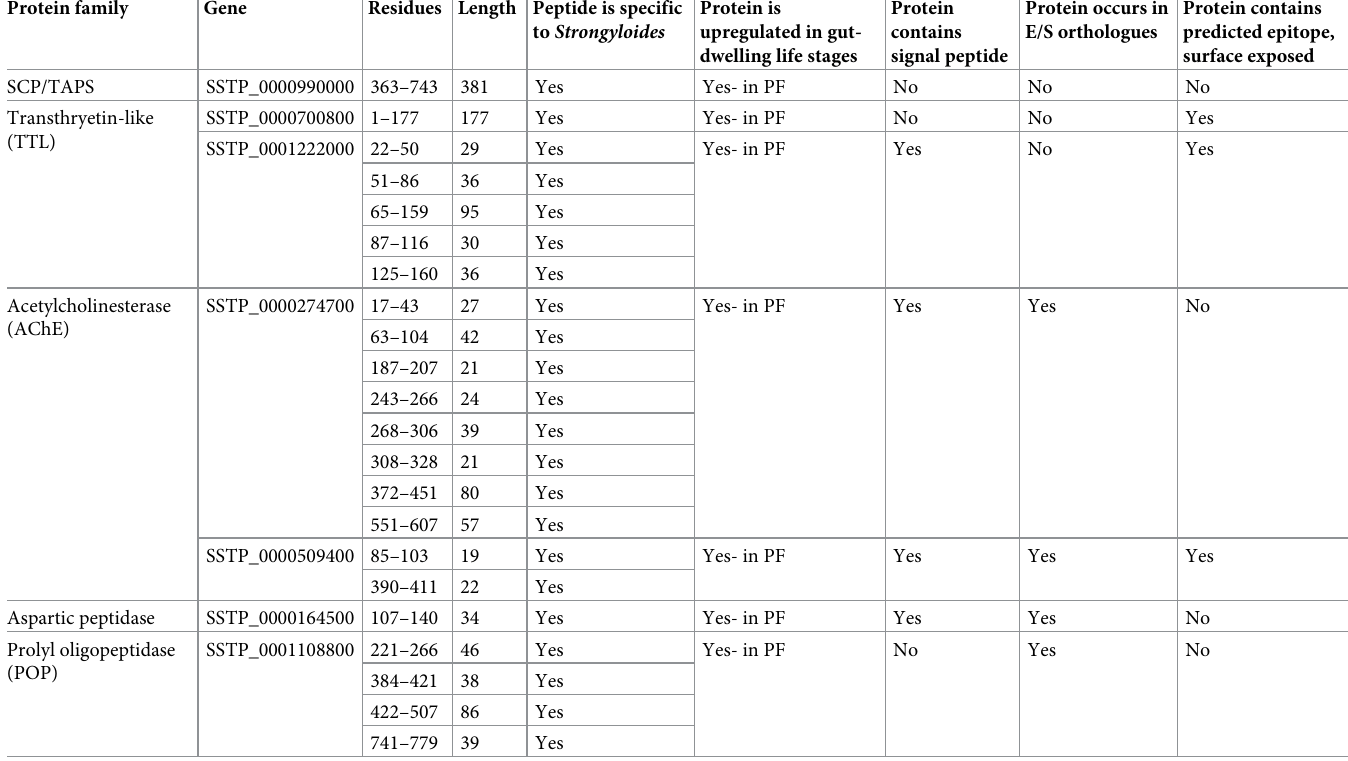
Table 3. Candidate coproantigens of S . stercoralis based on upregulation in parasitism, amino acid sequence specificity to Strongyloides or S . stercoralis , and con- taining a predicted epitope. Gene accession numbers can be found in WormBase ParaSite or UniProtKB. Amino acid sequences are given in S6 File. PF: parasitic female, E/S: excretory/secretory. Protein family Gene Residues Length Peptide is specific